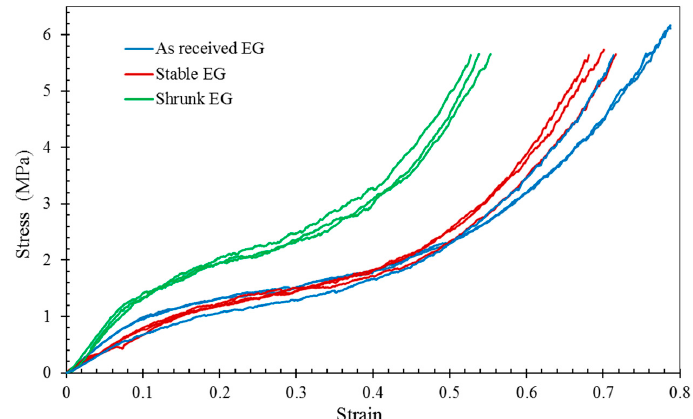
Figure 4. Crushing strength of as-received, stable (held for 6 min at 700 °C) and shrunk EG (held for 20 min at 700 °C).